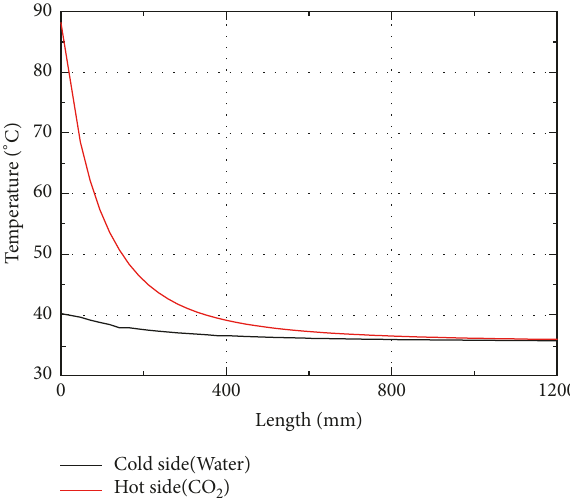
Figure 8: Temperature distribution of water and s-CO2 side predicted by SCTRAN/CO2 for test